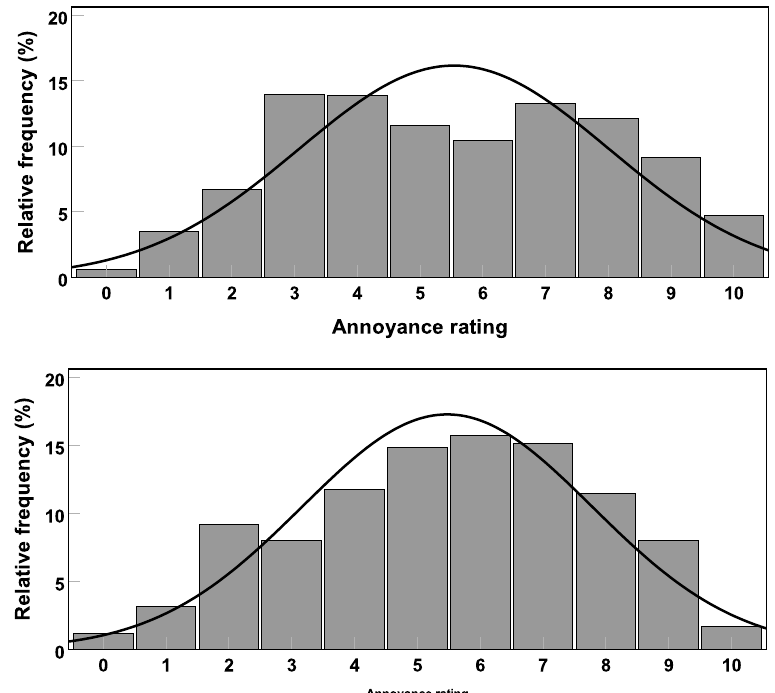
Figure 9. Annoyance rating histograms for the data from experiments 1 ( above ) and 2 ( below ). Relative frequency is shown in percentages. The black curve shows the normal